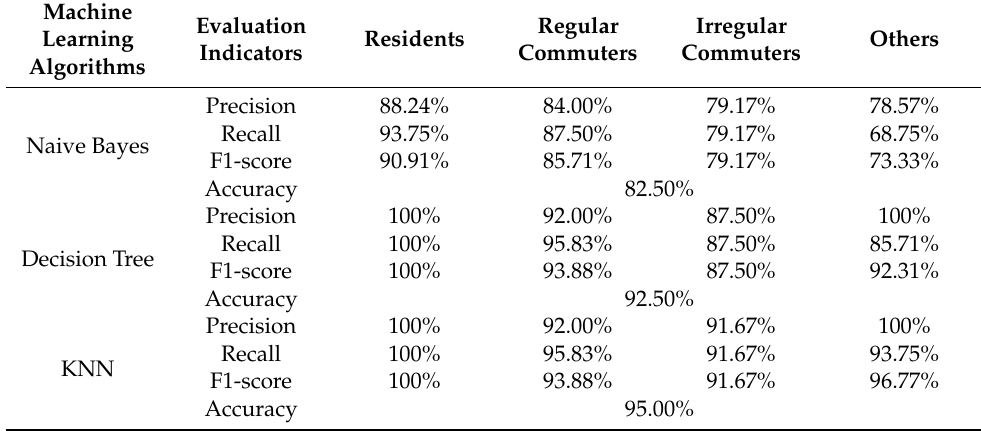
Table 4. Comparison of evaluation indicators based on different classification models.